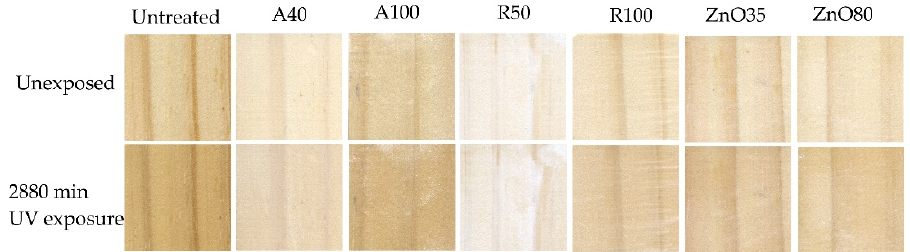
Figure 8. Appearance of wood samples treated with anatase 40 nm (A40), anatase 100 nm (A100), rutile 50 nm (R50), rutile 100 nm (R100), ZnO 35–45 nm (ZnO35), ZnO 80–200 nm (ZnO80), and untreated control samples before and after UV exposure.